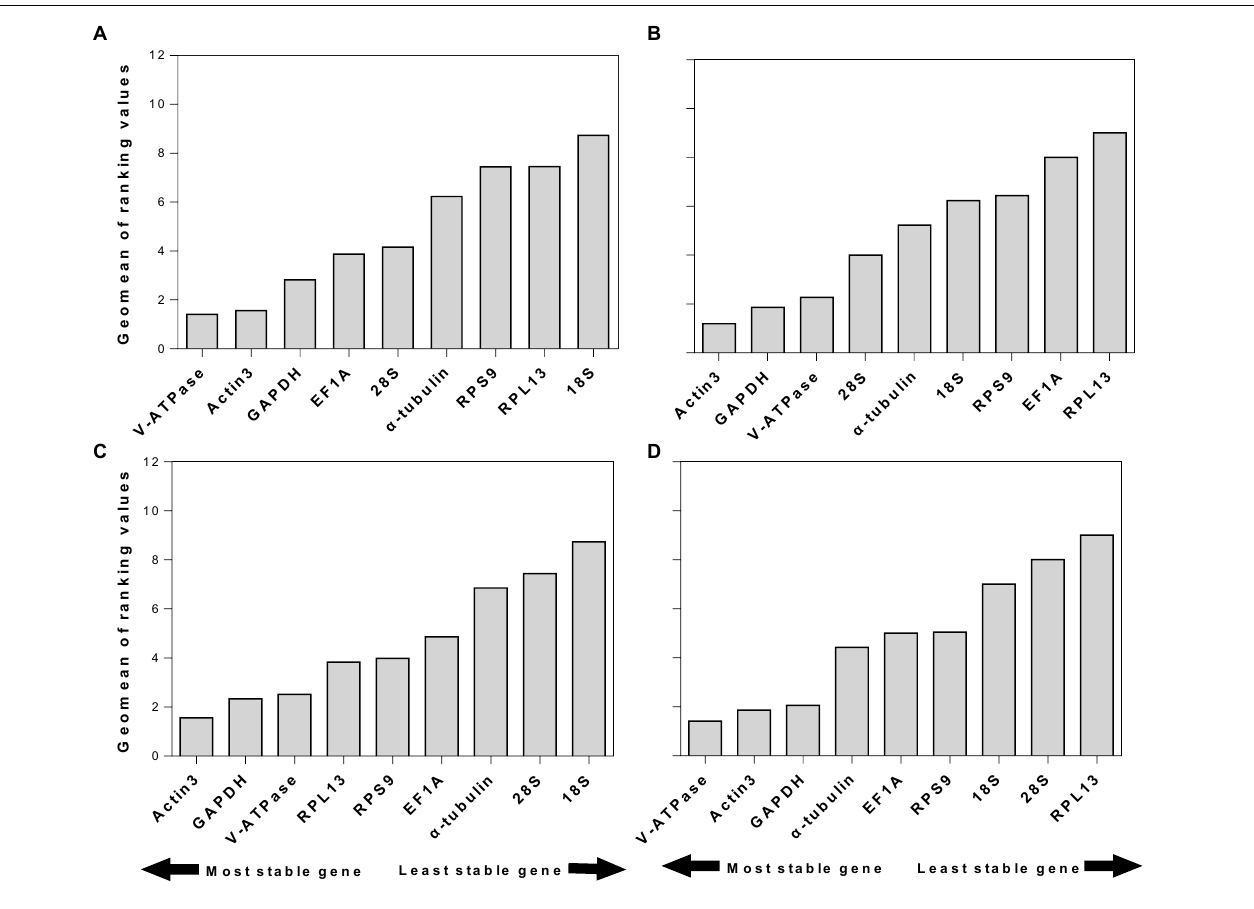
FIGURE 3 | Stability of candidate reference genes under different intrinsic conditions. The intrinsic conditions included different developmental stage (A) , sex (B) , diapause (C) , and all three conditions combined (D) . The final stability ranking was provided a comprehensive ranking system, RefFinder, which integrates all four computational platforms used in this study. A lower Geomean value denotes stable expression.